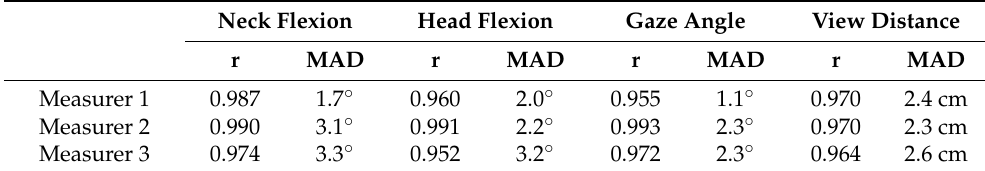
Table 1. Correlation analysis (r) and mean absolute difference (MAD) of intraobserver reliability for the three